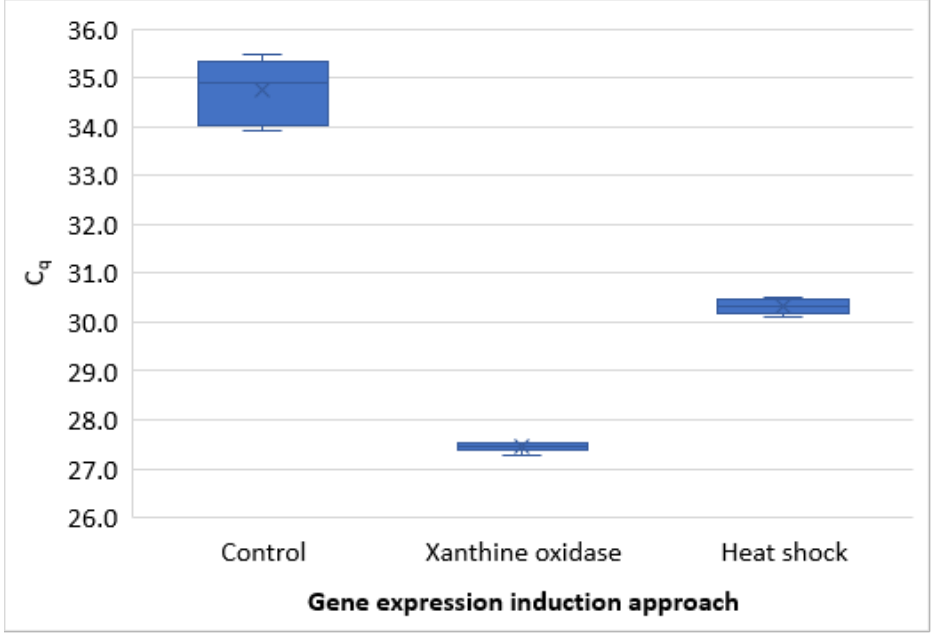
Figure 4. Comparison of gene expression induced by heat shock (45 °C for 20 min) with that induced by oxidative stressor challenge catalyzed by xanthine